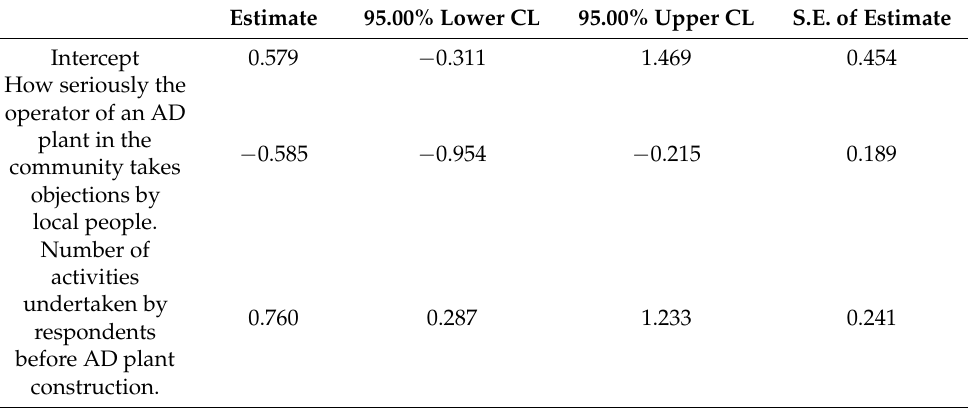
Table 4. Regression estimates.